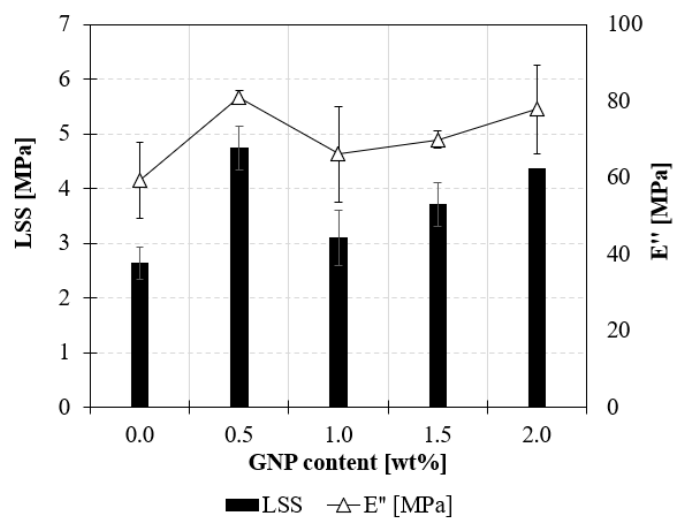
Figure 7. Comparison between LSS and loss modulus for nanocomposites reinforced with HAR nanoplatelets.